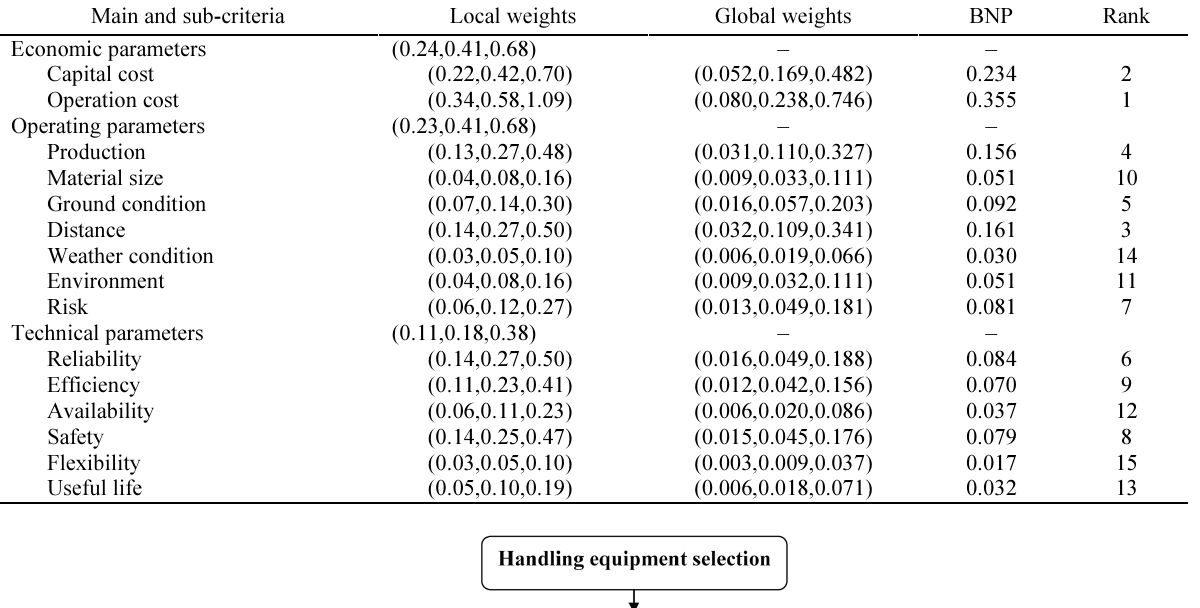
Table 5. Relative weight of the evaluation criteria